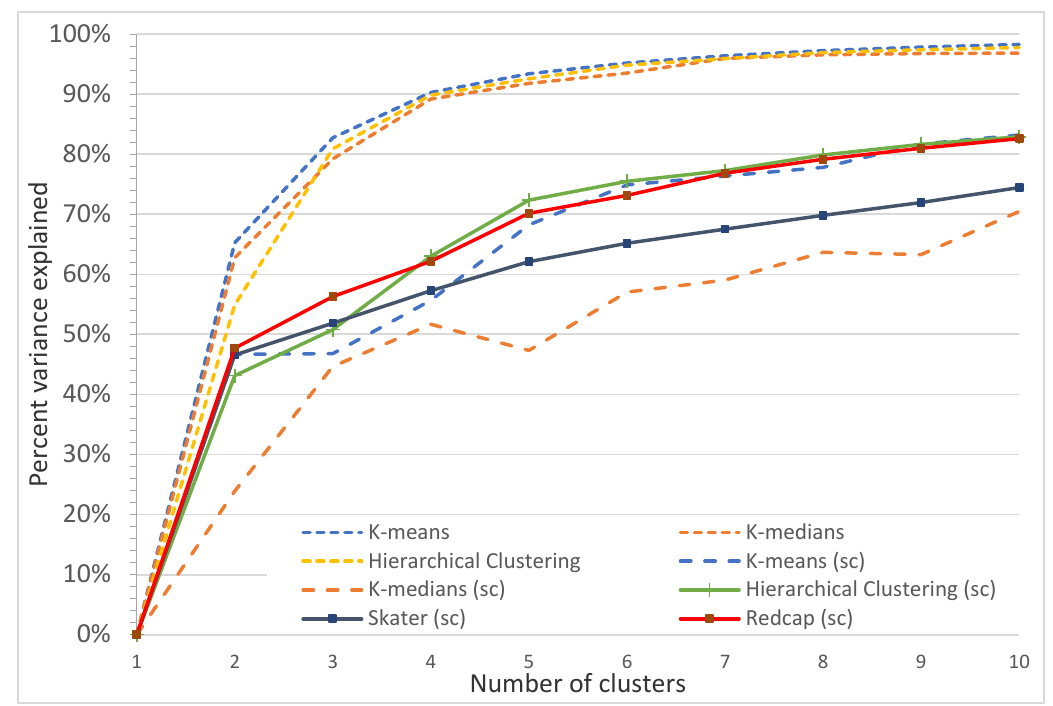
Figure A15. Plot of the percentage of variance explained as a function of the number of clusters generated by eight algorithms for the Sunshine Coast study site. This elbow plot indicates that 2–4 classes is the optimum, e.g., for nonspatial algorithms, 3 classes explain 82.7% (K-means), 79.2% (K-medians), and 80.9% (Hierarchical clustering) of the variance, and 4 classes explain 90.3% (K-means), 89.2% (K-medians), and 90.0% (Hierarchical clustering) of the variance. In comparison, spatially constrained algorithms (sc) explain a maximum of 56% (3 classes) and 63% (4 classes) of the variance.